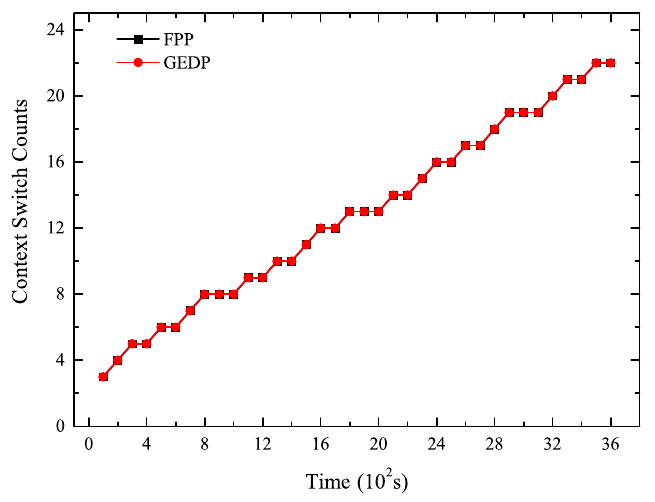
Figure 10. Voluntary context switches of Whetstone.